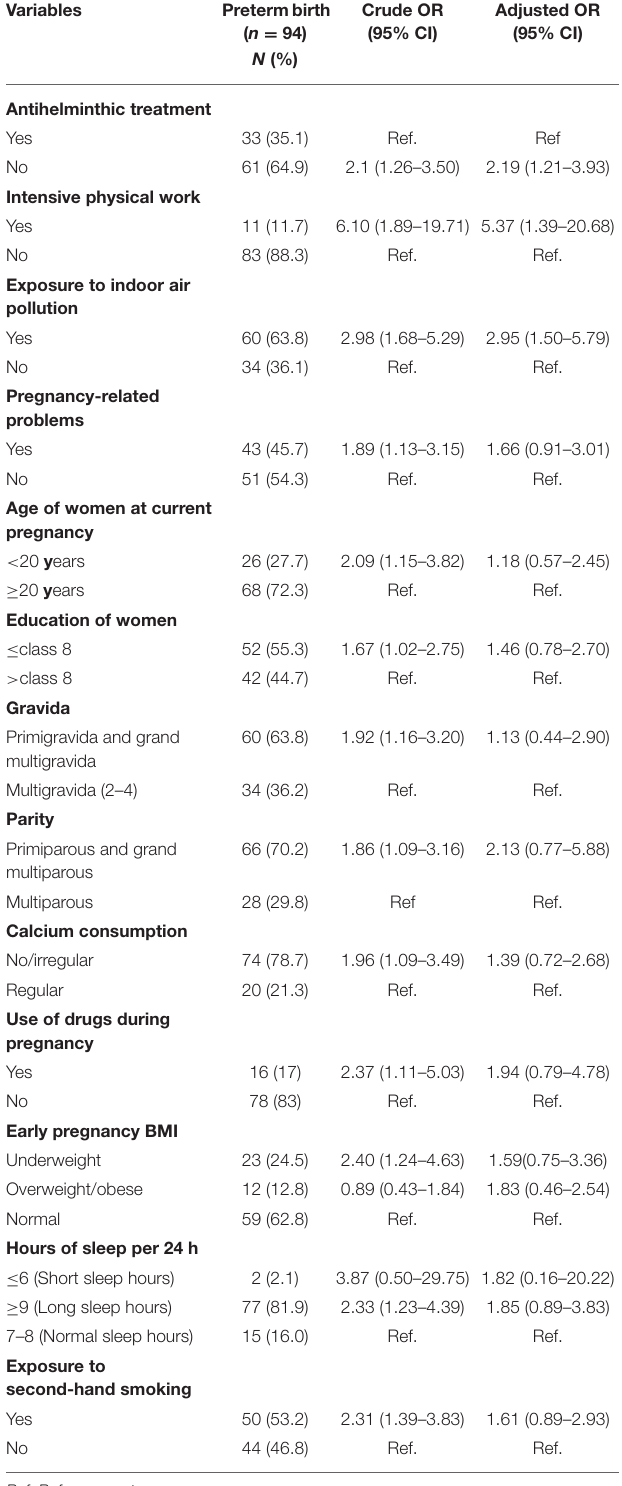
TABLE 7 | Predictors of preterm